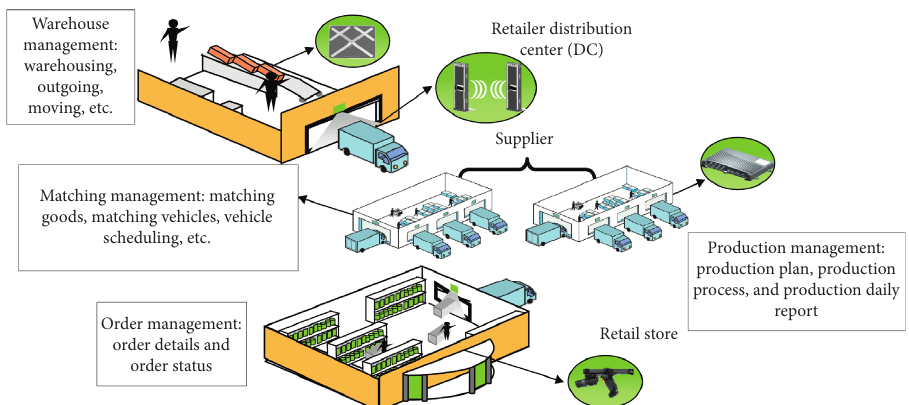
Figure 3: The specific system function